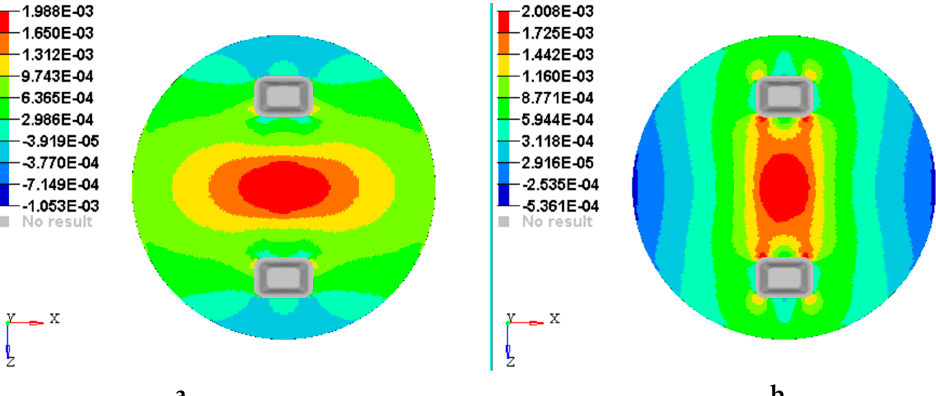
Figure 14. Plot of the strains on the bottom face of layer 1: ( a ) Strains ε x with respect to Ox axis; ( b ) strains ε z with respect to Oz axis.